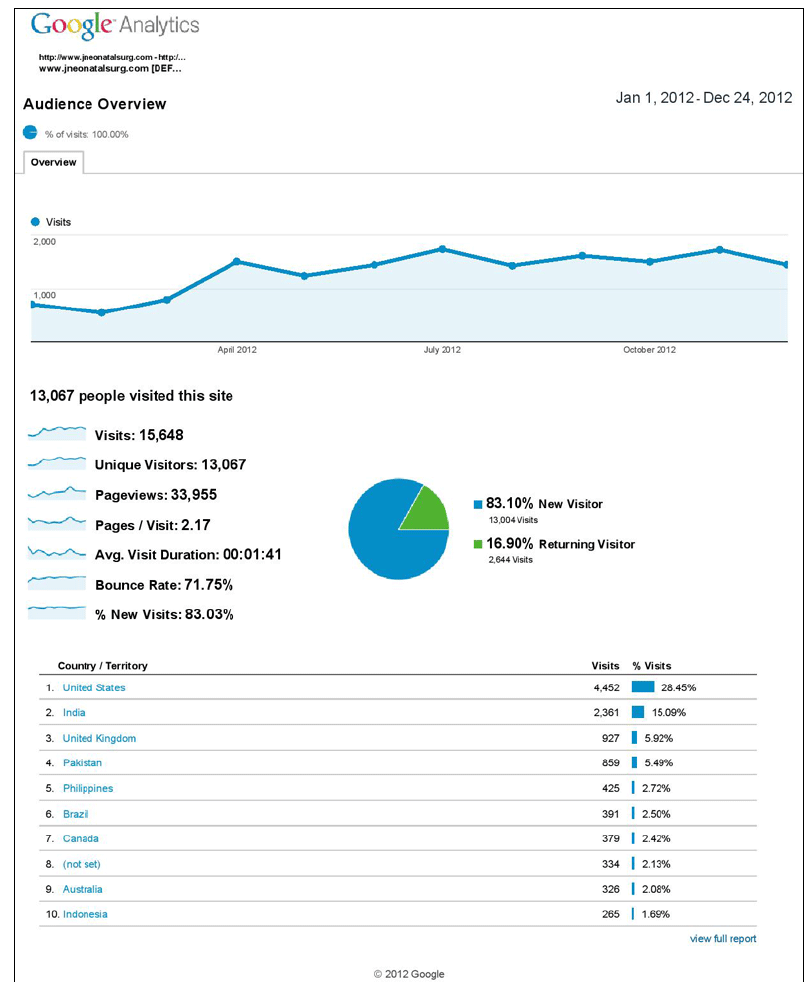
Figure 1: Journal’s one year